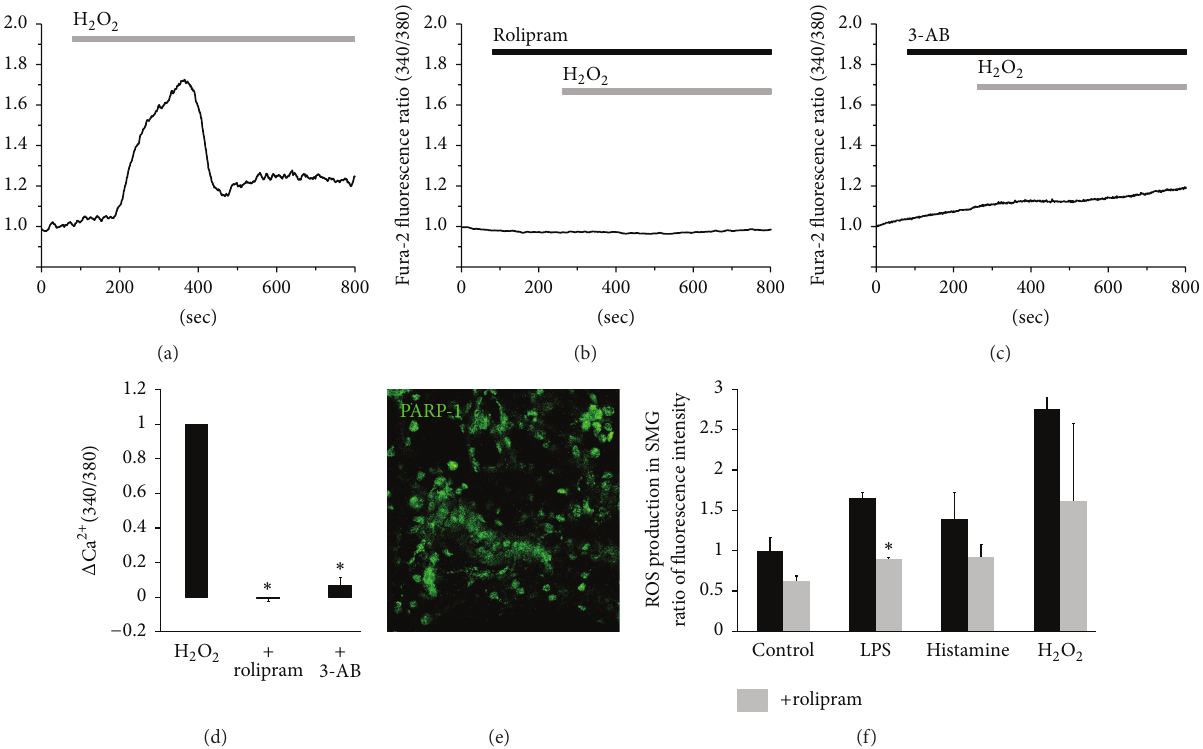
Figure 2: Rolipram prevents H 2 O 2 -induced [ Ca 2+ ] i signals and intracellular ROS production in SMG acinar cells. (a) Changes in [ Ca 2+ ] i induced by 1mM H 2 O 2 . Changes in [ Ca 2+ ] i induced by 1mM H 2 O 2 , pretreatment with 10 𝜇 g/mL rolipram (b) and with 10 𝜇 M 3-AB (c). The traces are averaged traces ( 𝑛 = 4 ). The upper bars indicate the extracellular solutions applied to the cells. (d) Analysis of H 2 O 2 -induced maximum [ Ca 2+ ] i peak as determined using R340/380 fluorescence ratios ( ∗ 𝑃 < 0.01 ). (e) Expression of PARP-1 (green) in SMG tissue. (f) Effect of inflammatory mediators for 30 min in the absence or presence of rolipram (R) on intracellular ROS production in SMG cells. Results are expressed as ratio of control and mean ± SEMs are shown ( 𝑛 = 3 , ∗ 𝑃 < 0.01 compared with